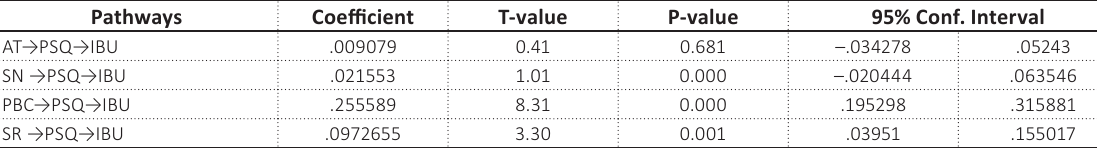
Table 5. Structural equation model with mediation